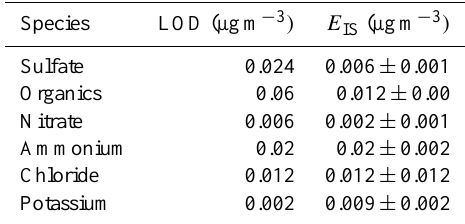
Table 1. Limit of detection (LOD) and statistical ion counting error ( E IS )